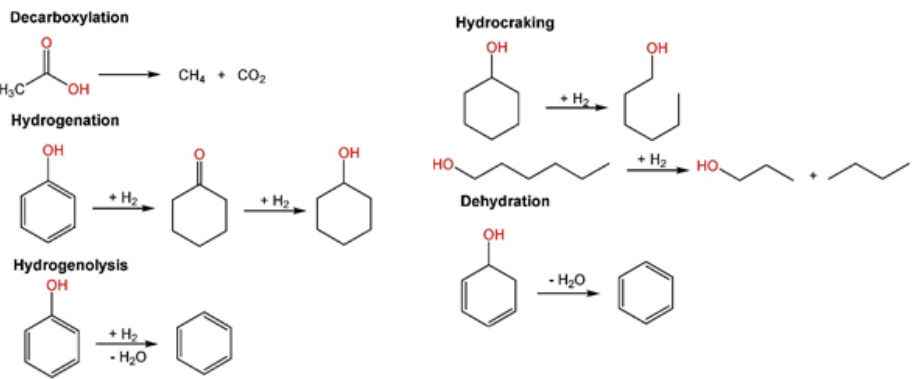
Figure 1. Typical reactions taking place in the hydrodeoxygenation. Adapted with permission from [23]. Copyright 2018, copyright